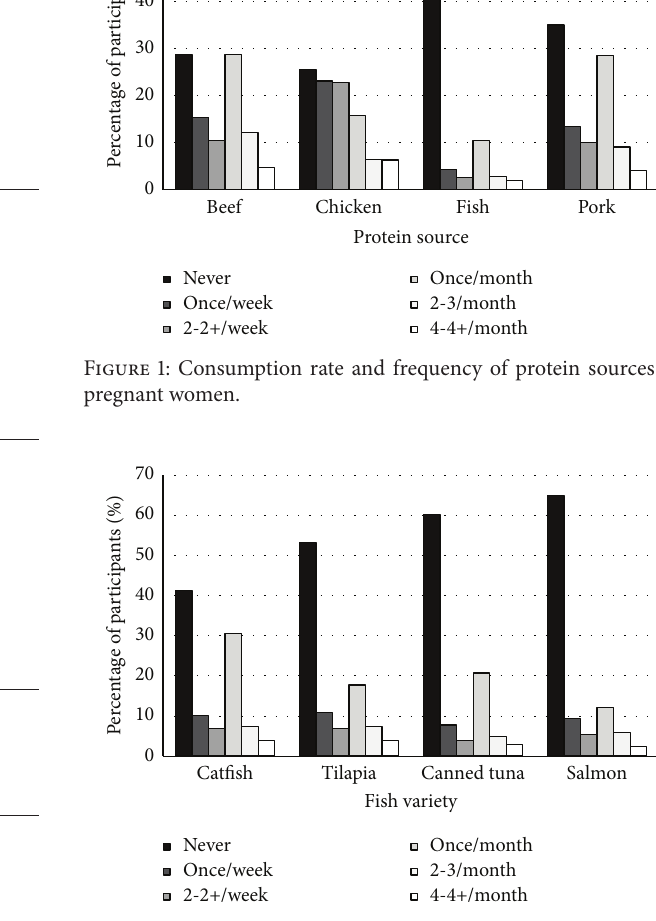
Figure 2: Consumption rate and frequency of the more consumed fish varieties by pregnant